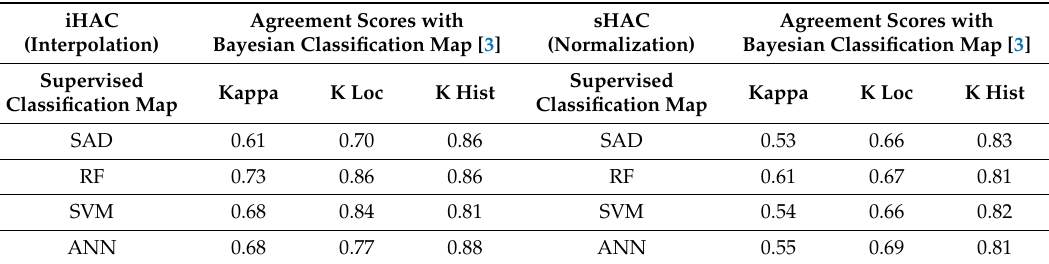
Table 2. Agreement scores between classification maps produced with the interpolated hyper-angular cube (iHAC), the synthetic hyper-angular cube (sHAC) data and the Bayesian classification map from Reference [3], calculated using the Map Comparison Kit. SAD—sum of absolute